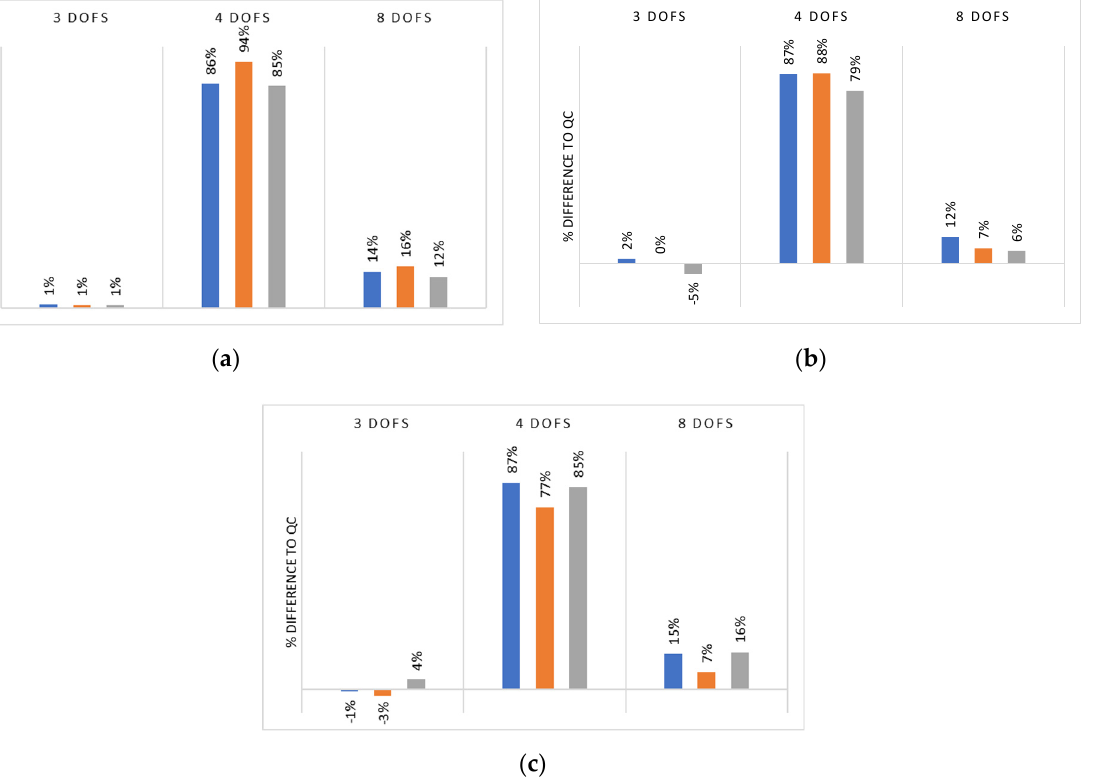
Figure 16. The percent difference of the RMS values of the acceleration of the top DOF of all models to the RMS values of the acceleration of the top DOF of the QC model for road profiles of ( a ) Class A, ( b ) Class C and ( c ) Class E (blue = 5 km/h, orange = 10 km/h and grey = 15 km/h).